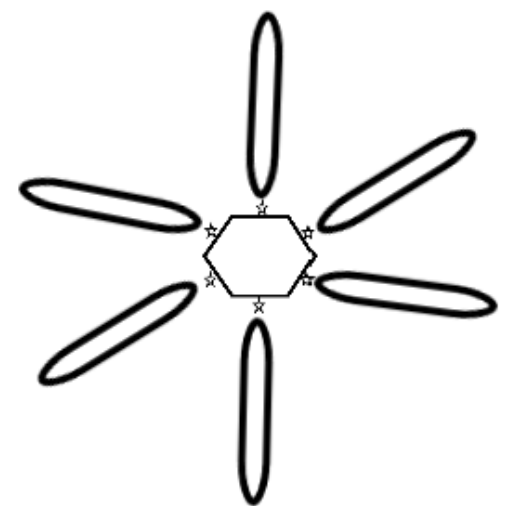
Figure 6: Schematic modelling of the nanoflower growth for high value of the pH of the suspension during sonochemical processing. The stars are the active sites and the hexagon is the ZnO nucleus.